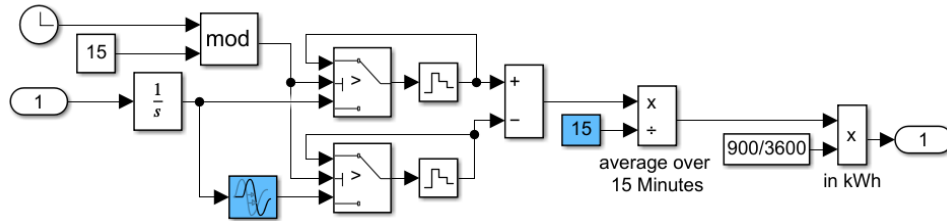
Figure 11. Calculation of waste heat energy supplied by the heat Figure 11 . Calculation of waste heat energy supplied by the heat exchanger.